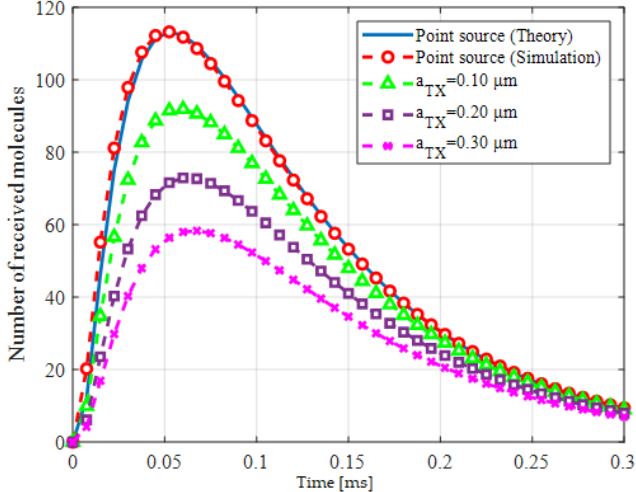
Figure 10. Number of received molecules considering the volume of transmitted molecules.